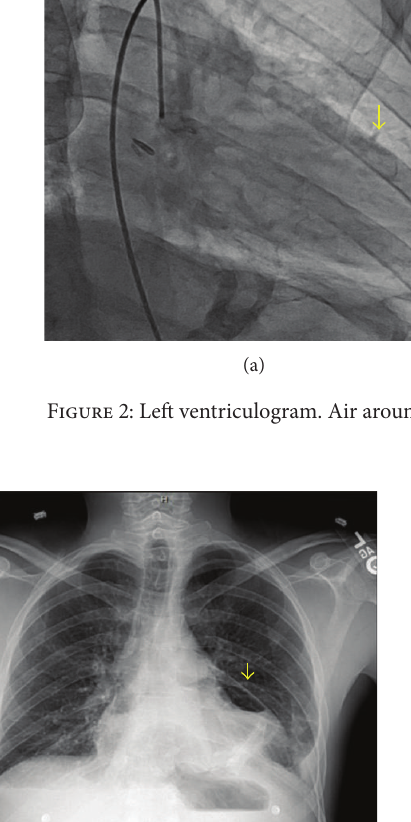
Figure 4: Chest computed tomography. There is an air fluid level in the pericardial space.